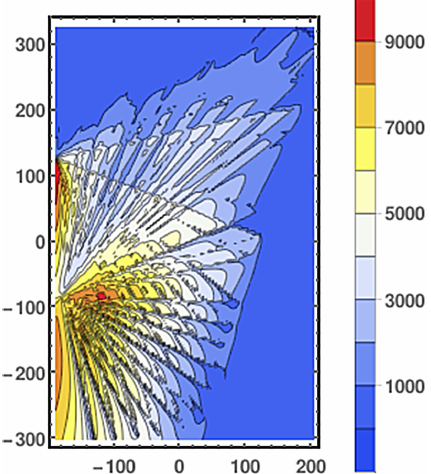
Table 3. Results of calculations. Units of Q are